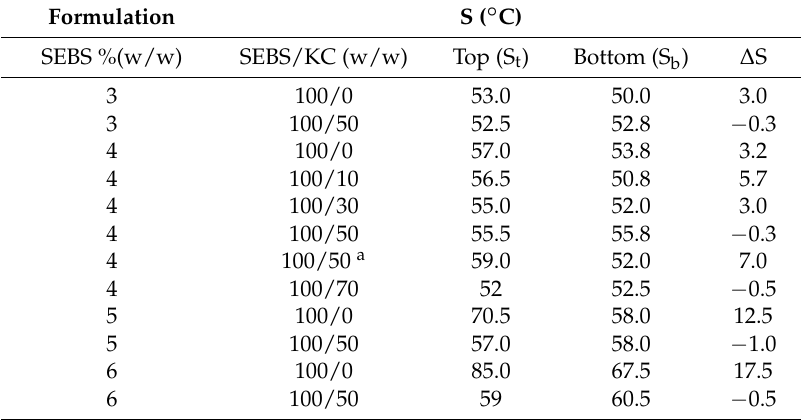
Table 3. SEBS/KC-modified bitumen storage stabilities at high-temperature (from Table 4 of [133] with the permission of